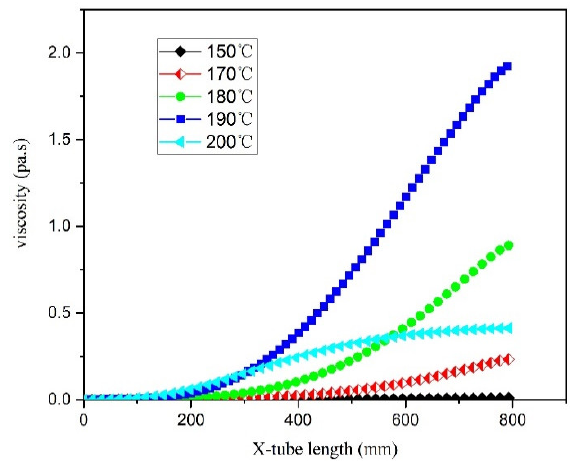
Figure 15. Viscosity curve in the microreactor at different jacket temperatures.